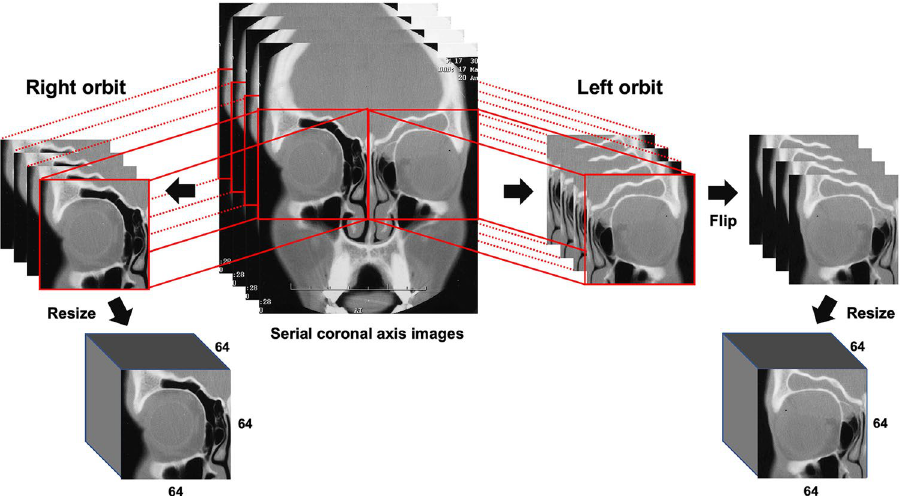
Figure 6. Preprocessing of CT images. Only coronal axis view orbital CT images were selected. Orbital areas were extracted, and each left orbit was flipped to match the shape of the right orbit images. Finally, the images in one CT were resized to 64 × 64 × 64 voxels with one channel.